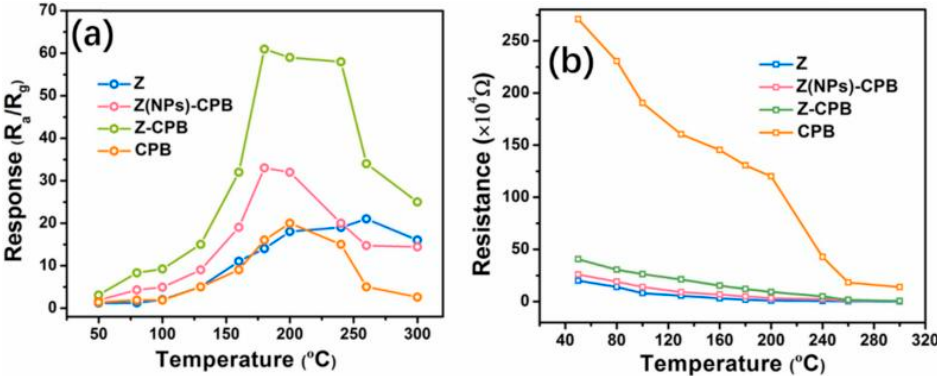
Figure 16. ( a ) Responses of as-obtained sensors versus different temperatures to 100 ppm of TEA. ( b ) The plots of Ra change for all sensors at different working temperatures to 100 ppm of TEA [112].